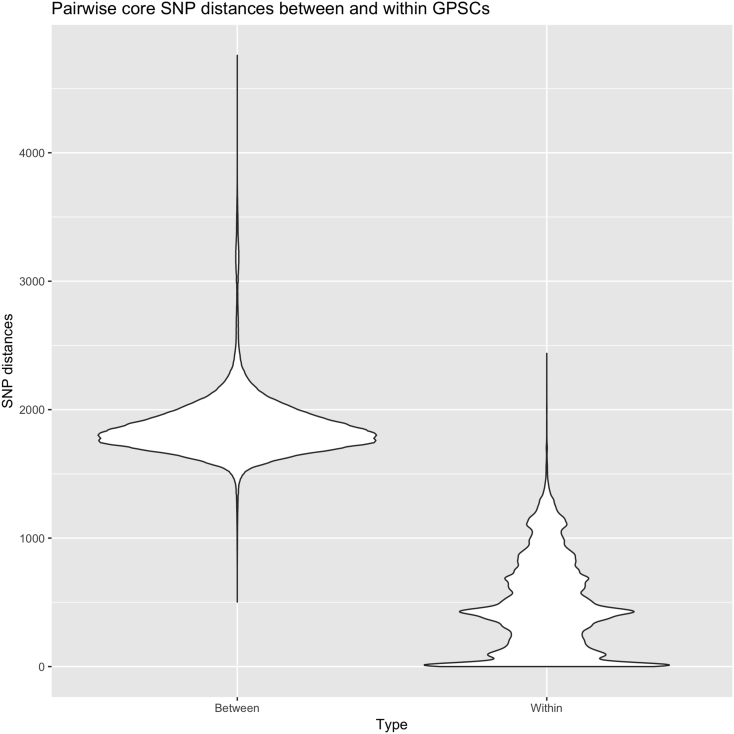
Pairwise core SNP distances between and within GPSCs.Pairwise SNP distances, from a core alignment generated using Roary, between isolates in different GPSCs (left) are generally greater than pairwise SNP distances for isolates within the same GPSC (Right).